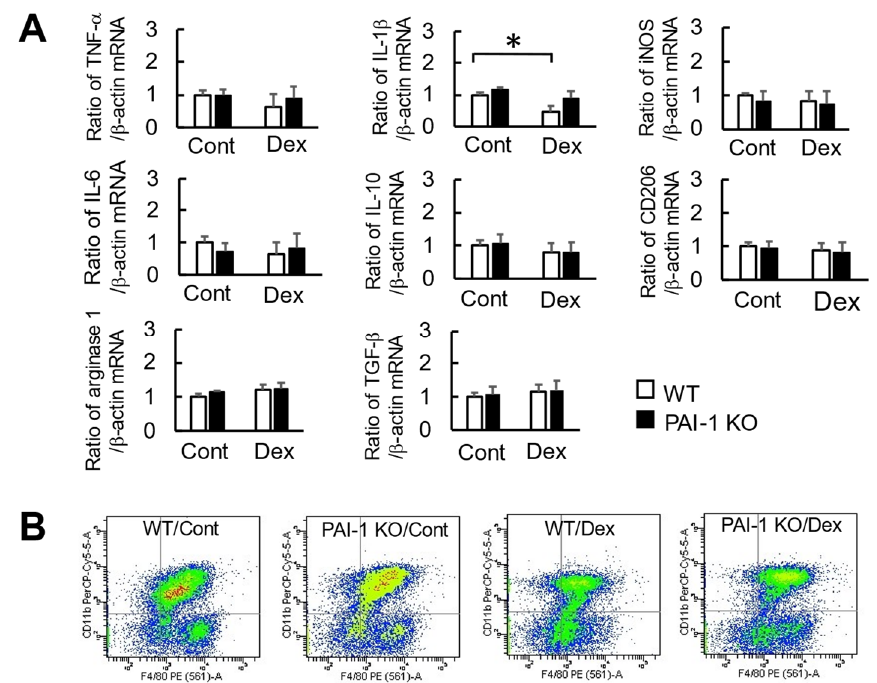
Figure 6. Effects of Dex and PAI-1 deficiency on the expression of macrophage-related factors in macrophages derived from the bone marrow of damaged femurs. ( A ) A real-time PCR analysis of TNF- α , IL-1 β , iNOS , IL-6 , IL-10 , CD206 , arginase 1 , TGF- β , and β -actin mRNA in F4/80 and CD11b double-positive cells derived from the bone marrow of damaged femurs 2 days after bone injury in mice using fluorescence-activated cell sorting. Data are expressed relative to 0 mRNA values. Data represent the mean ± SEM of 5 mice in each group. * p < 0.05. ( B ) Flow cutometric analysis was used to identify F4/80 and CD11b double-positive cells from damaged femurs 2 days after bone injury.